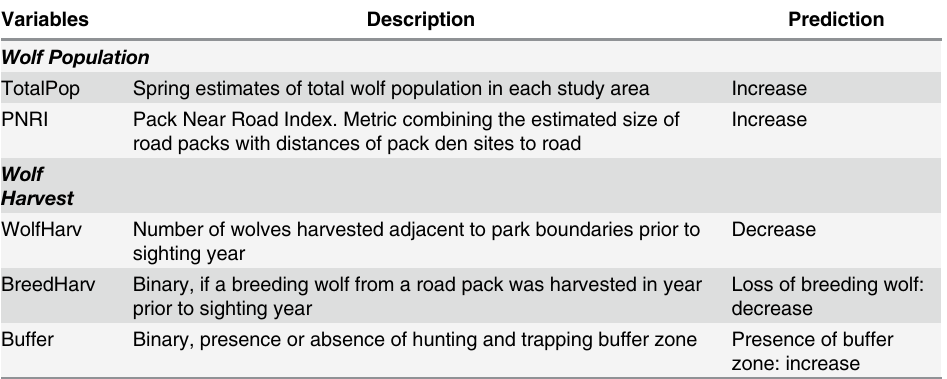
Table 2. Explanatory variables used to model annual probability of sighting rates in Denali National Park, Alaska, USA. Prediction column describes the predicted change in the response variable (annual probability of sighting) to an increase in the explanatory